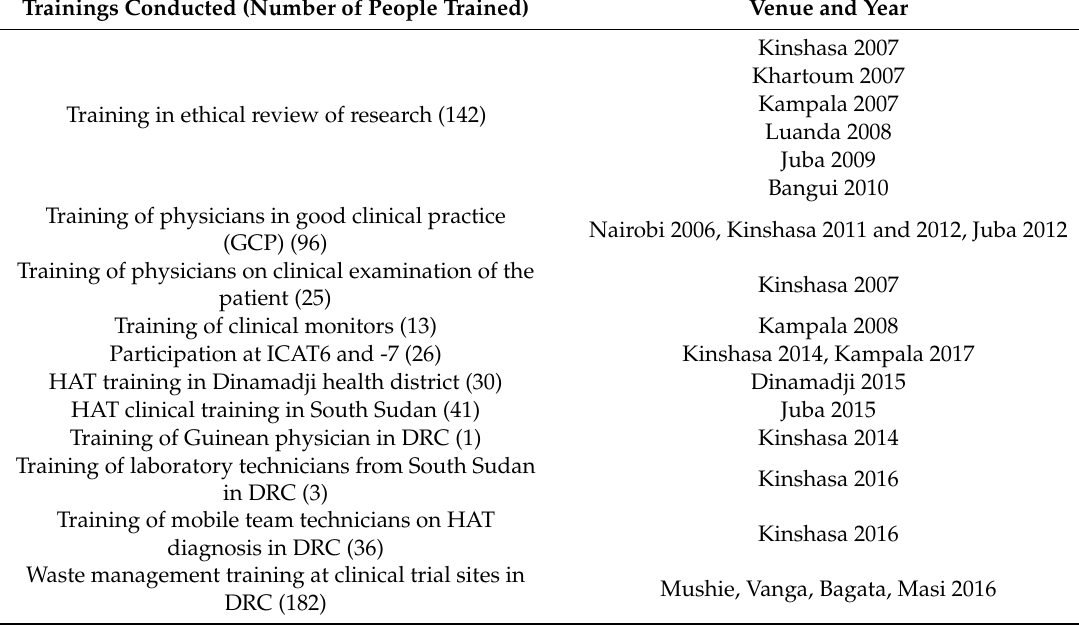
Table 1. The number of training sessions and people trained as part of HAT clinical trials since 2006 [5]. Trainings Conducted (Number of People